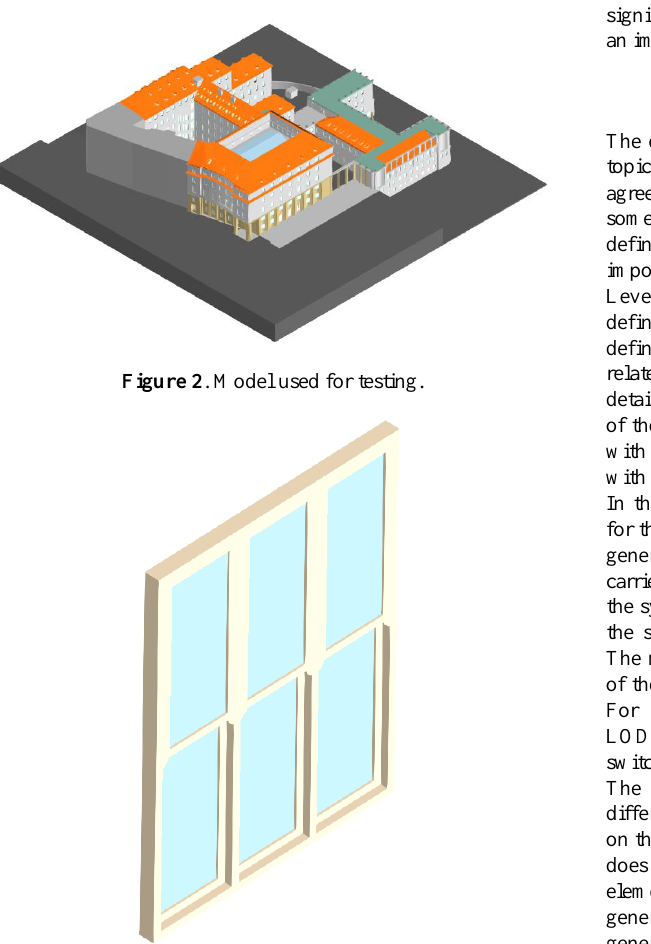
Figure 3 . Example of a window in full detail - Gen0 or